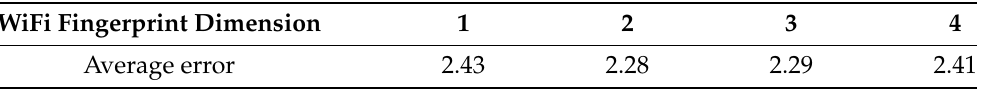
Table 3. Position errors